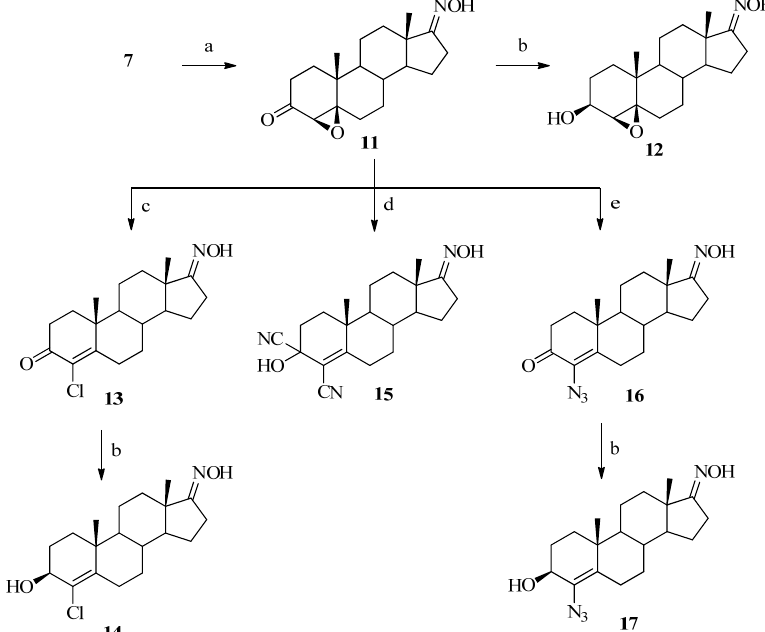
Scheme 2. Synthesis of 4-substituted androst-4-en-17-oxime